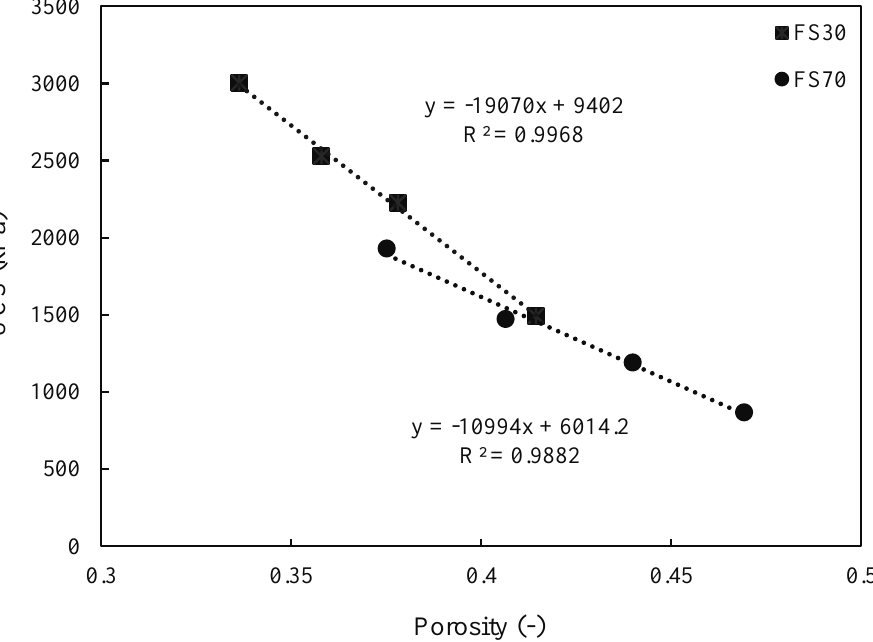
Figure 11. Relationships between porosity and compressive strength of FS30 and FS70 geopolymer- stabilized specimens.